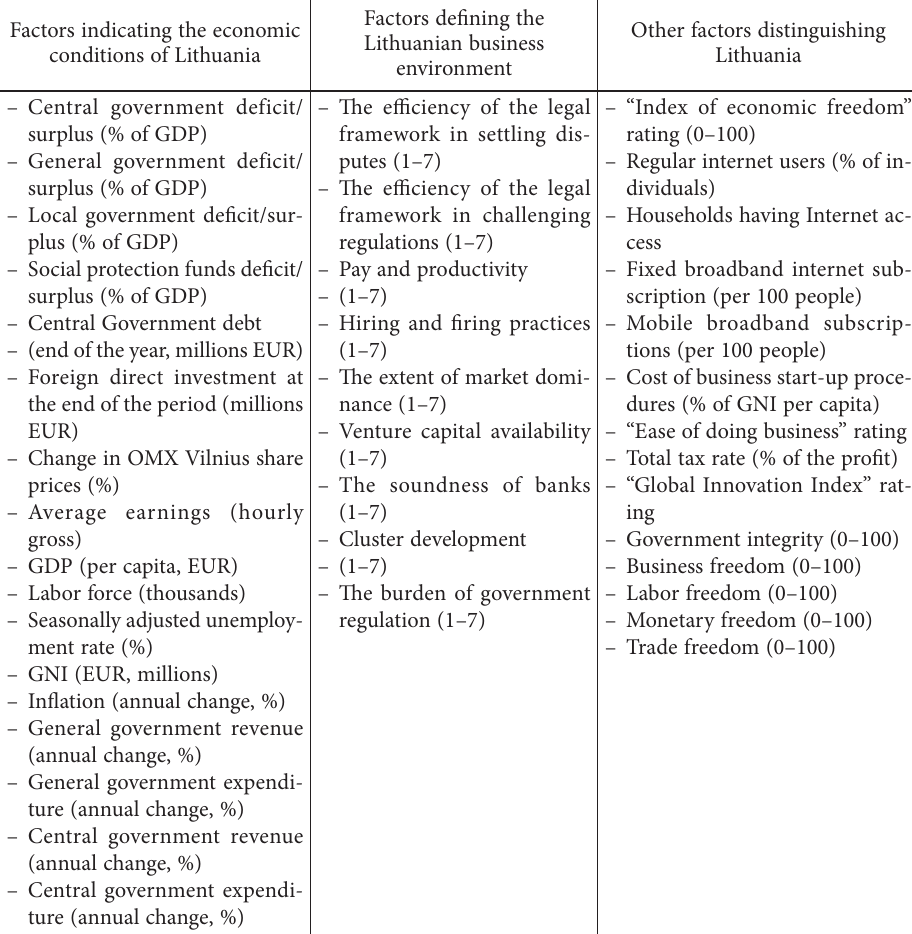
Table 2. Selected and grouped factors according to three separate groups (source: authors) Factors indicating the economic conditions of